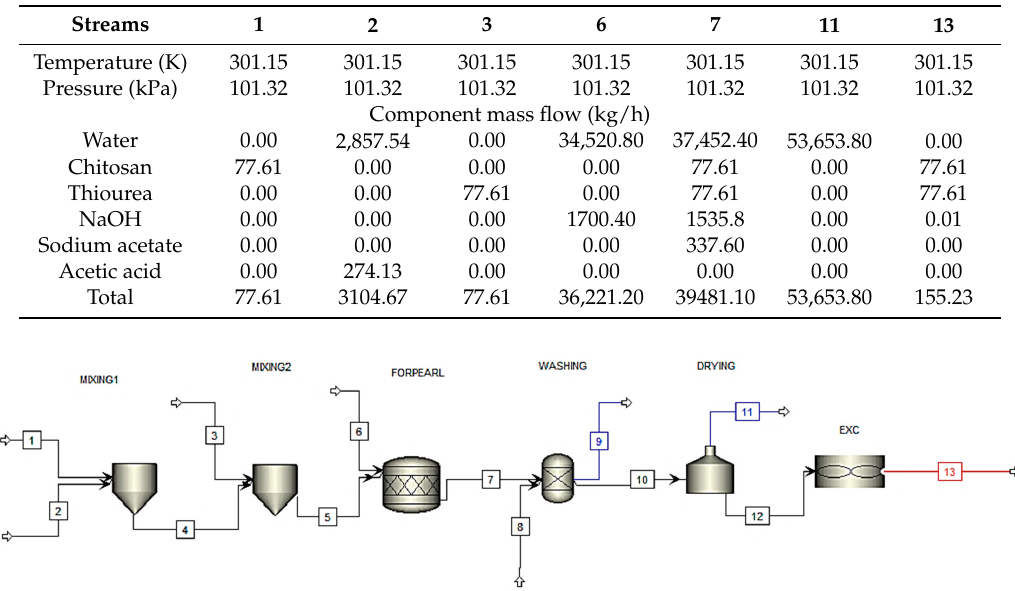
Table 4. Main process streams for chitosan microbeads modified with thiourea. Streams